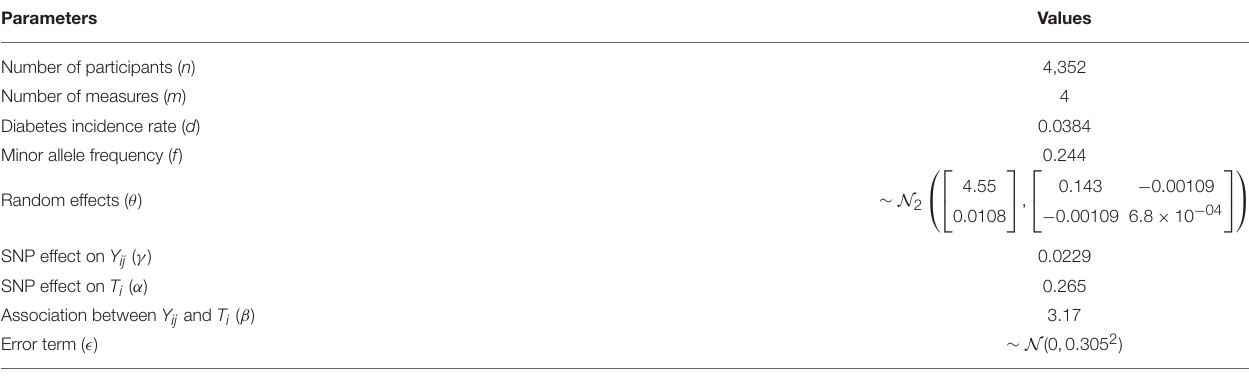
TABLE 1 | Parameters and numerical values used for sensitivity analysis and simulations, based on results from rs17747324 within gene TCF7L2 in the French cohort D.E.S.I.R.